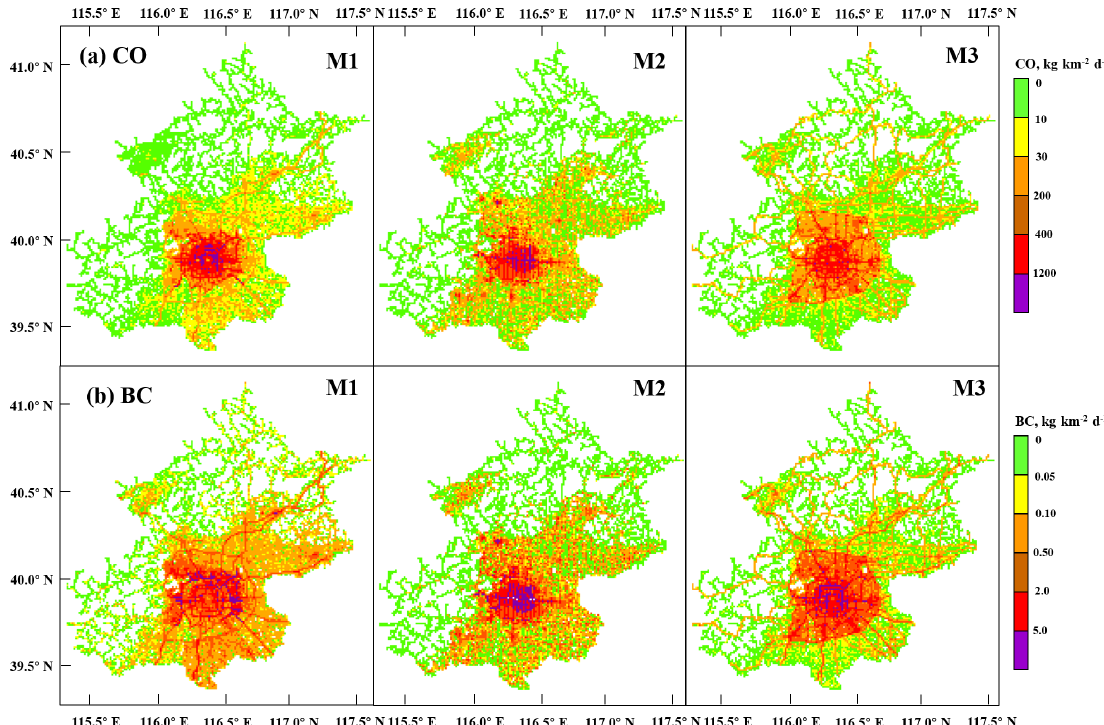
Figure 6. Comparison of link-level emission intensity of (a) CO and (b) BC developed by various